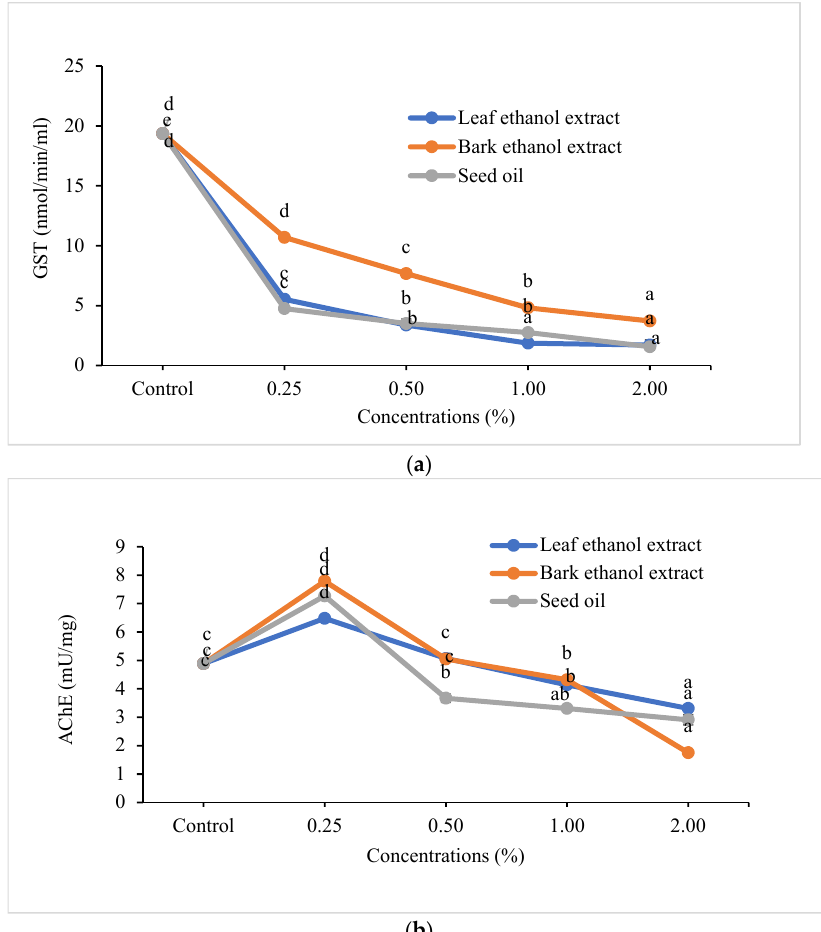
Figure 2. ( a ) Glutathione S-transferase enzyme (GST) inhibition in Plutella xylostella treated with leaf, bark ethanol aqueous extracts, and seed oil of Triadica sebifera ; Mean of three replications ( n = 3); The same letters in the error bars (Mean ± SE) within the figure are not statistically different by Tukey’s HSD ( p ≥ 0.05). ( b ). Acetylcholine esterase enzyme (AChE) inhibition in Plutella xylostella treated with leaf, bark ethanol aqueous extracts, and seed oil of Triadica sebifera ; Mean of three replications ( n = 3); The same letters in the error bars (Mean ± SE) within the figure are not statistically different by Tukey’s HSD ( p ≥ 0.05).